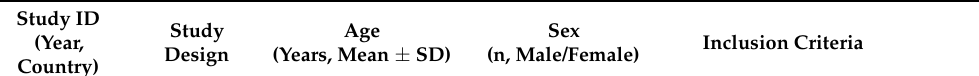
Table 1. Basic characteristics of the included